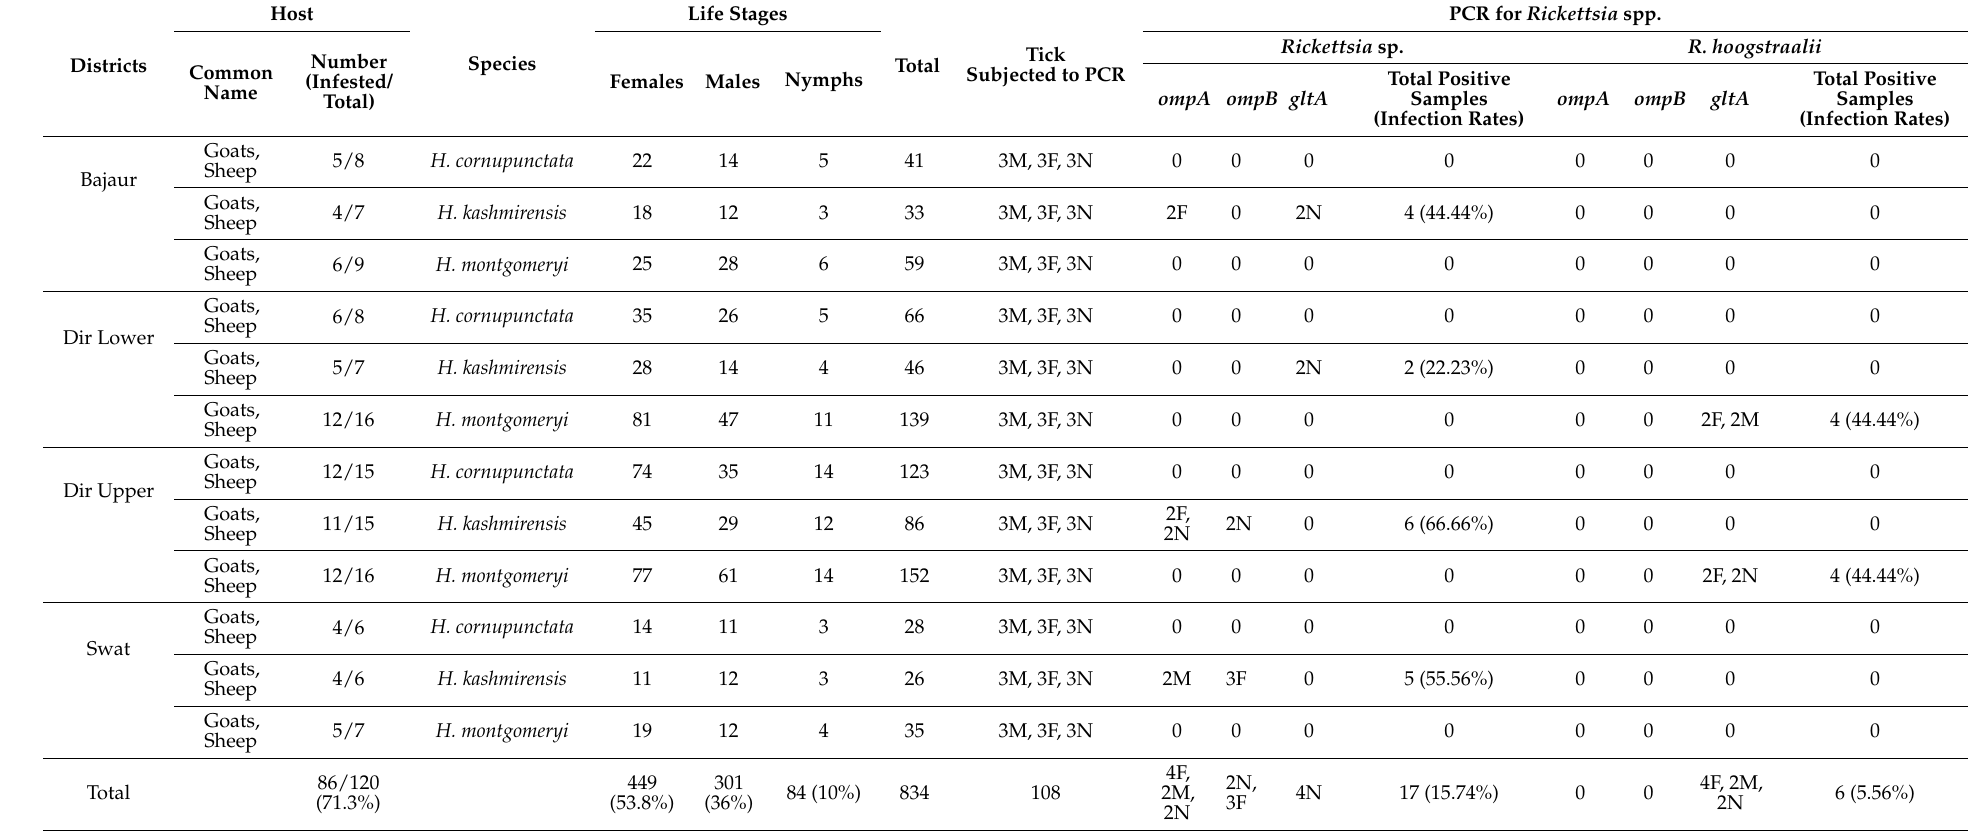
Table 2. Data on the number of ticks and hosts, and detection of Rickettsia spp. by polymerase chain